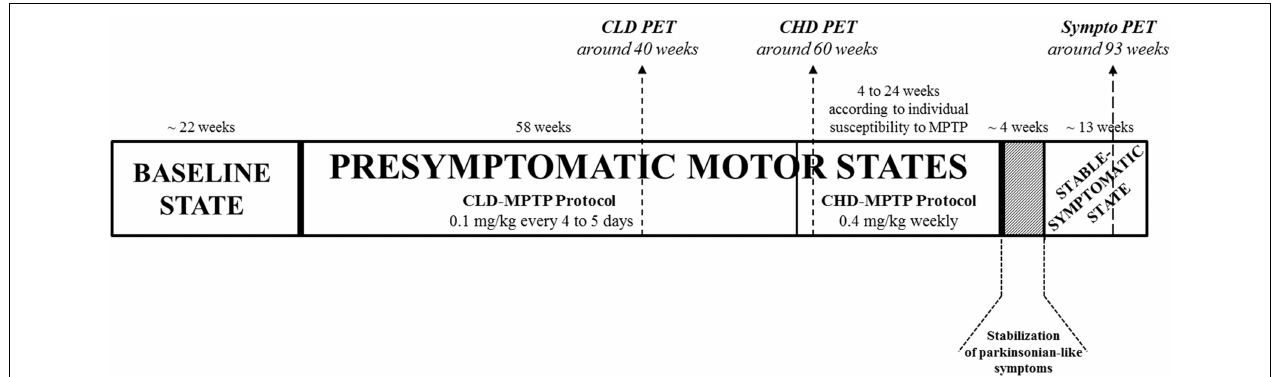
FIGURE 1 | Experimental design. Animals had been previously trained for cognitive testing, and their social and motor behaviors were assessed over the 5 months preceding MPTP administration in order to have a global representation of the baseline state. Then, all animals ( n = 6) were exposed to MPTP hydrochloride (MPTP-HCl) by systemic intramuscular (i.m.) administration. Firstly, animals received 0.1mg/kg every 4–5 days for 58